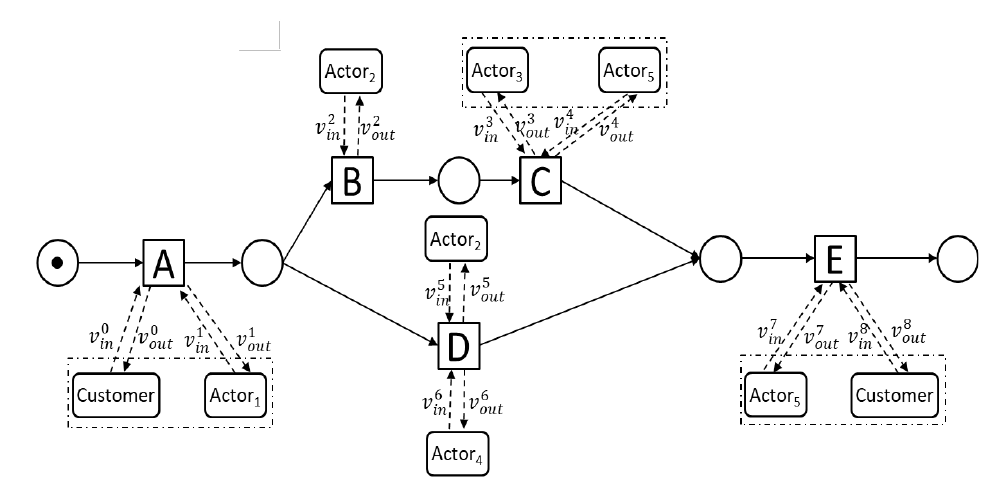
Figure 8. The general form of the service value model.